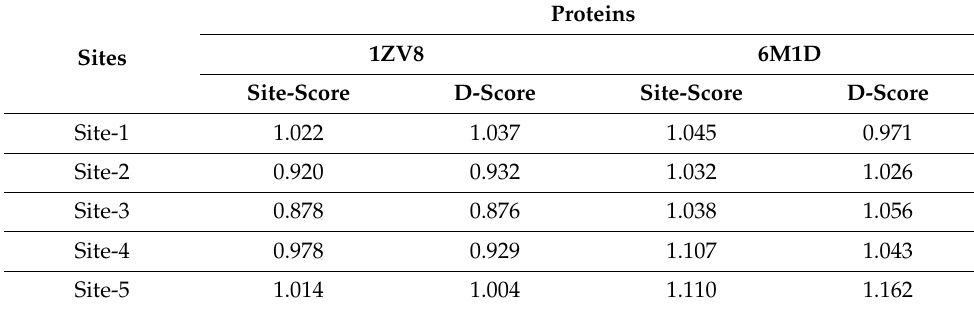
Table 2. Site-score and D-score for the sites on 1ZV8 and 6M1D.